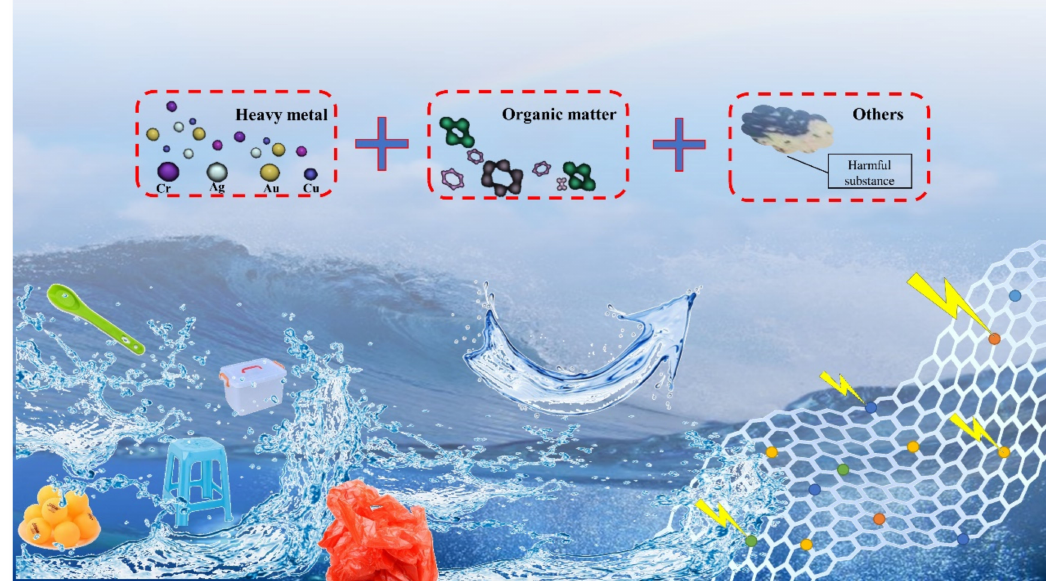
Figure 5. The adsorption machines in the process of adsorbing pollutants with